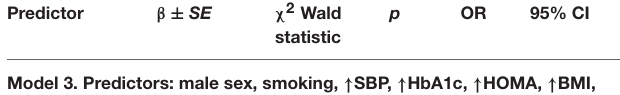
TABLE 8 | Results of logistic regression analysis in younger group, where the presence of AP is a dependent variable. p OR 95% Predictor β ± SE χ 2 Wald statistic